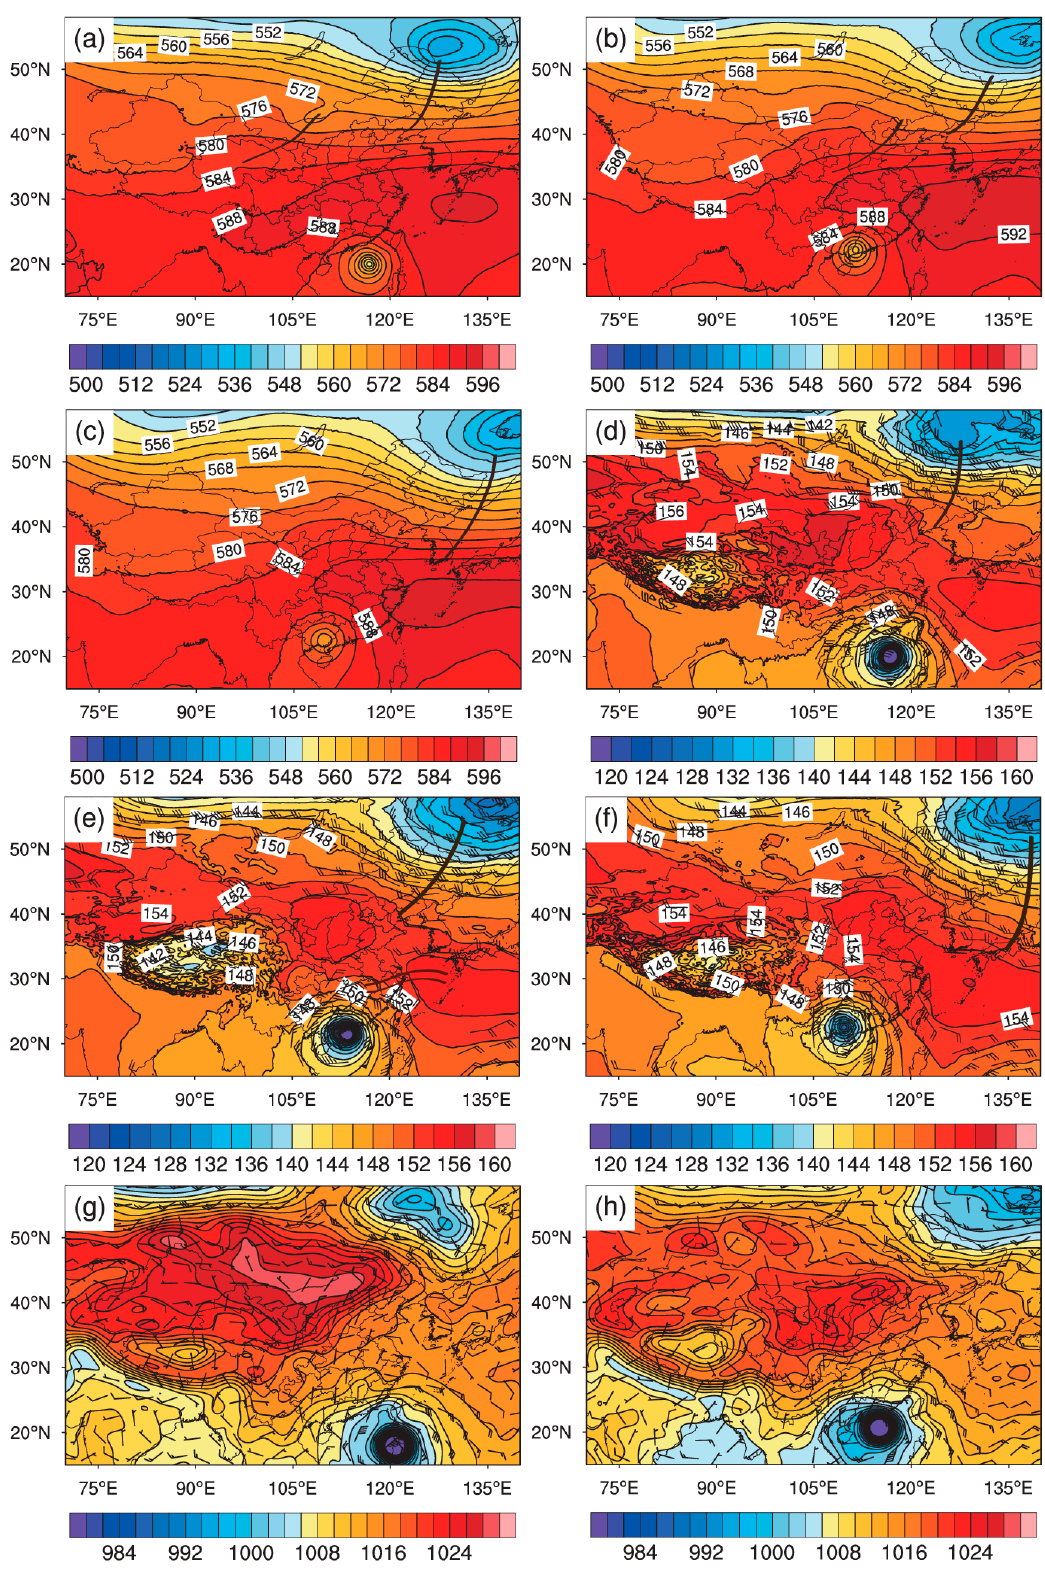
Figure 4. Geopotential height (dagpm) at 500 hPa at ( a ) 1800 UTC 15 September, ( b ) 1200 UTC 16 September, and ( c ) 1800 UTC 16 September 2018, geopotential height (dagpm) and winds (m · s − 1 ) at 850 hPa at ( d ) 1800 UTC 15 September, ( e ) 0600 UTC 16 September, and ( f ) 1800 UTC 16 September 2018, and sea level pressure (hPa) at and winds (m · s − 1 ) at ( g ) 0000 UTC 15 September and ( h ) 0000 UTC 16 September 2018. Thick curves denote troughs